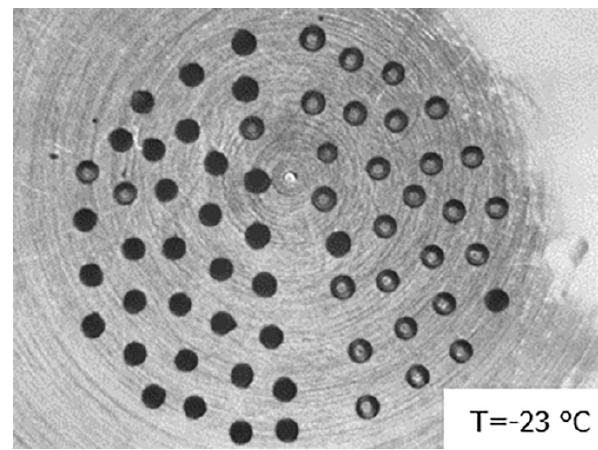
Figure 12. Image of droplets containing biomass burning aerosol (left half) and pure water droplets (right half) immersed in squalene oil on a silanized glass cover slip. Droplets containing aerosol sam- ple have mostly frozen (turned dark) and pure water droplets have remained largely unfrozen (grey) at − 23 ◦